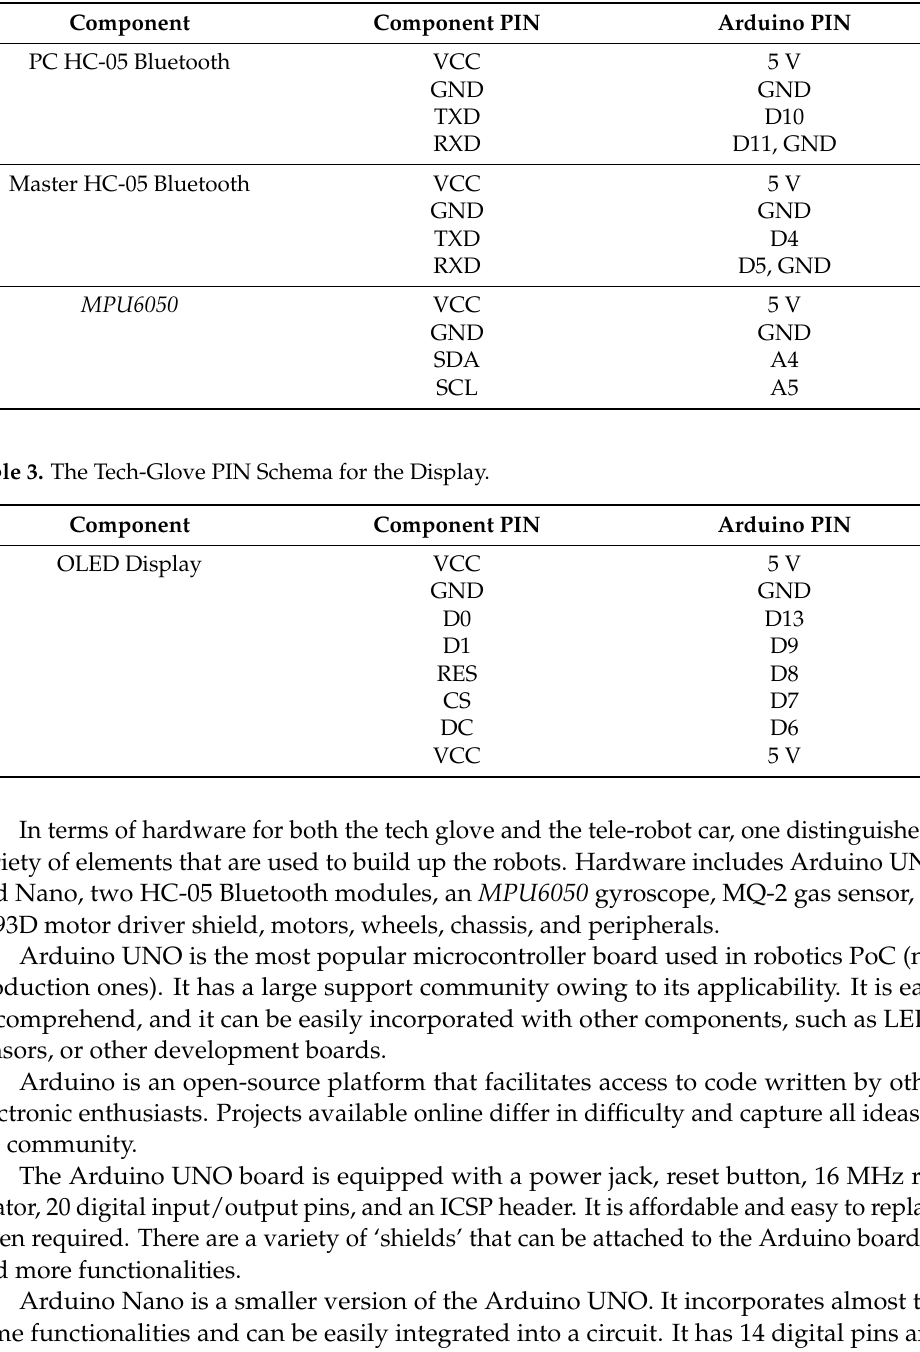
Table 2. The Tech-Glove PIN Schema.